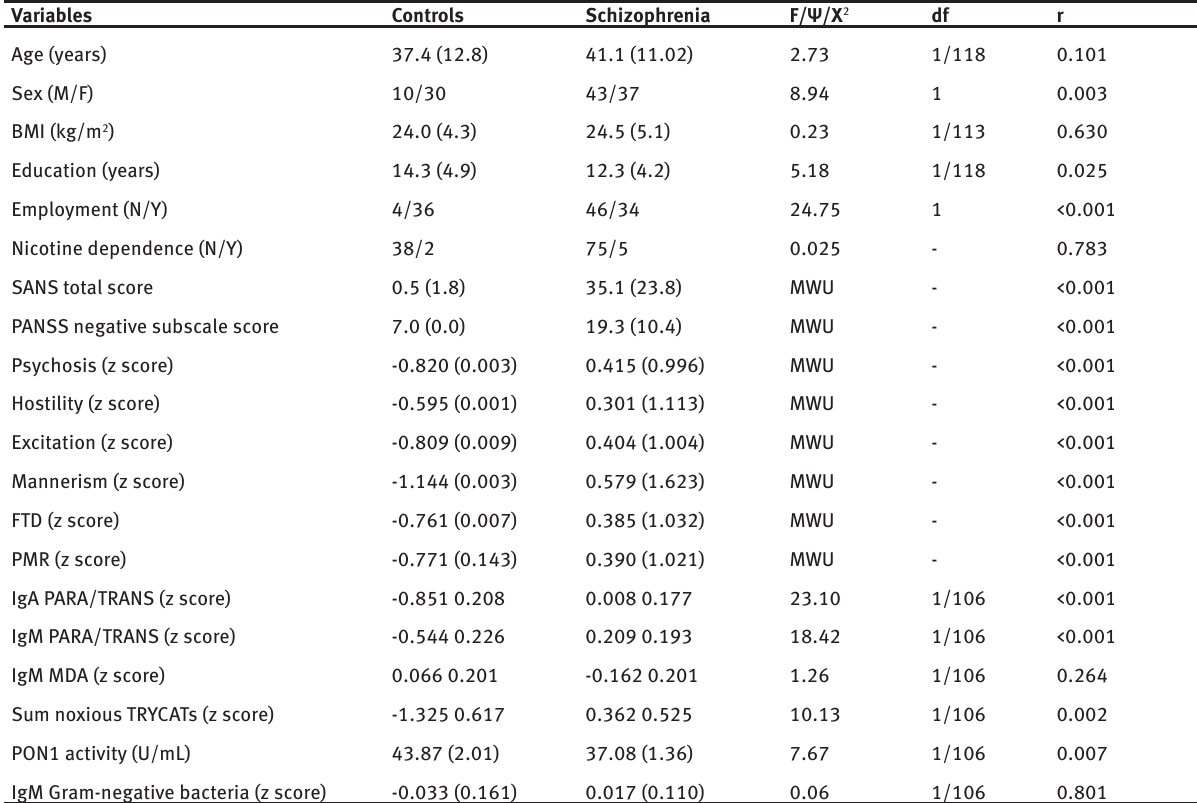
Table 1: Demographic and clinical data in normal controls and schizophrenia patients Variables